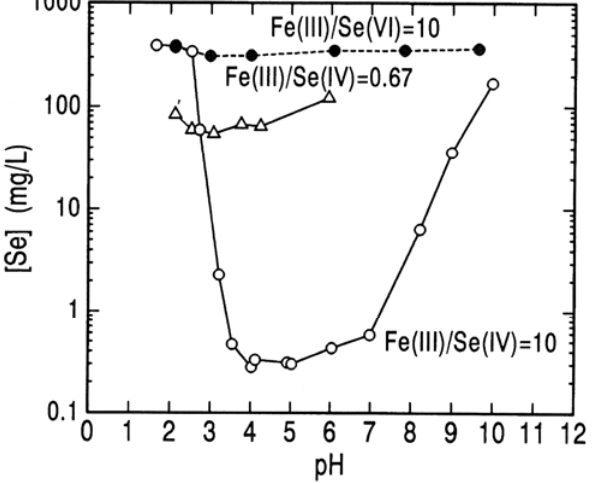
Figure 11. Removal of selenium(IV) and selenium(VI) by precipitation with ferric species = 0.005 M ( = 395 mg/L); 25 °C; 2 at different pH. [Se] o